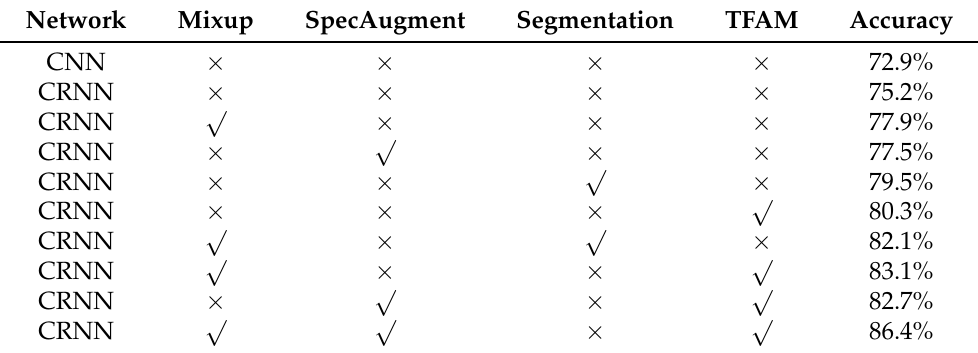
Table 11. Comparison for different combinations of CNN, RNN, miuxp, SpecAugment, segmentation, and TFAM.